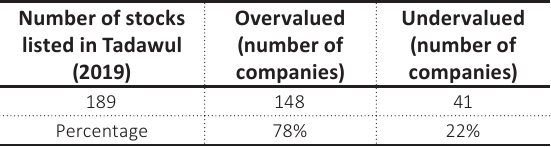
Table 1. Valuation of stocks listed in Tadawul